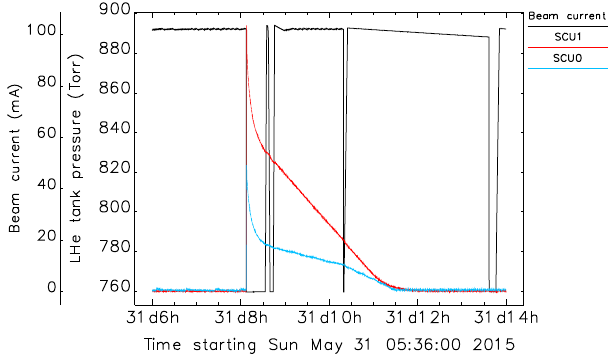
FIG. 14. Comparison of SCU recovery after a beam-dump- induced quench, as measured by the LHe tank pressure. Prior to the quench, the average magnet temperature was 4.23 K for SCU1 and 4.34 K for SCU0, and the main coil current was 450 A for SCU1 and 668 A for SCU0.